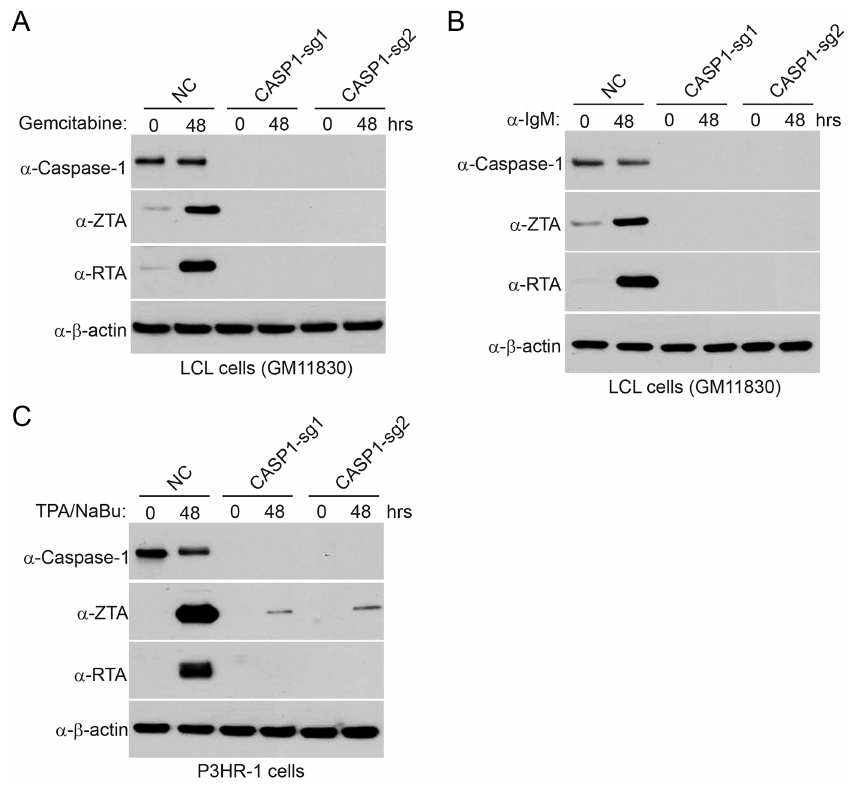
Fig 7. CASP1 depletion suppresses EBV reactivation in LCL and P3HR-1 cells upon lytic induction. A and B. Control (NC) and CASP1 -depleted (sg1 and sg2) LCL cells were either untreated (0 hr) or treated with 1 μ g/mL gemcitabine (A) or 20 μ g/mL α -IgM (B) for 48 hrs to induce lytic replication. Western blot analyses showing caspase-1, ZTA and RTA level as indicated. C. Control (NC) and CASP1 -depleted (sg1 and sg2) P3HR-1 cells were either untreated (0 hr) or treated with TPA (20 ng/ml)/sodium butyrate (NaBu, 3 mM) for 48 hrs to induce lytic replication. Western blot analyses showing caspase-1, ZTA and RTA level as indicated.